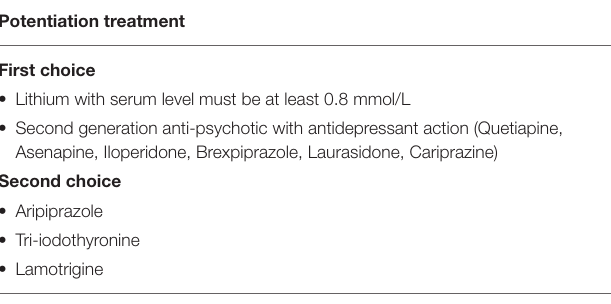
TABLE 2 | Treatment lines recommendations for clinical dimensions in MDD.